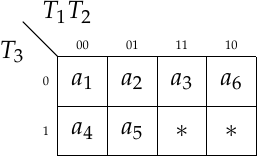
Figure 5. State codes of Mealy FSM U 4 ( S 1 ) .